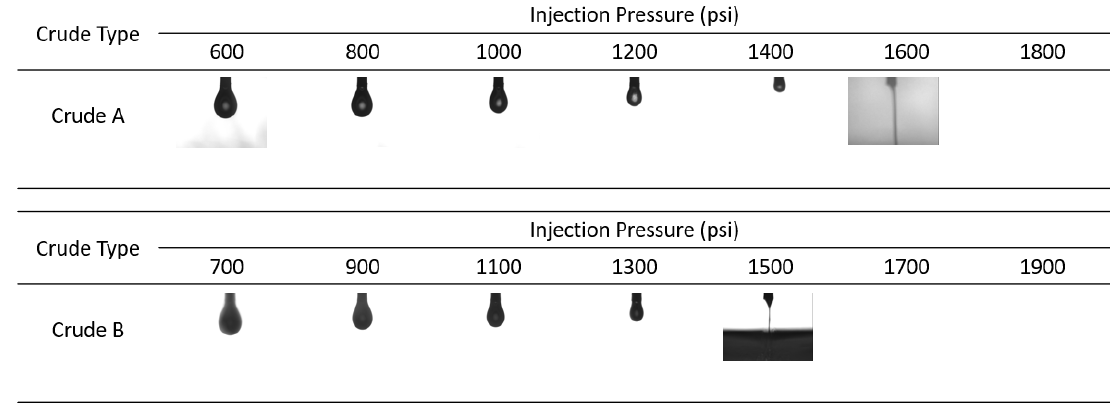
Figure 8. Oil-drop images of the mixture of CO 2 and 15 cm 3 acetone at 60 ◦ C. 265